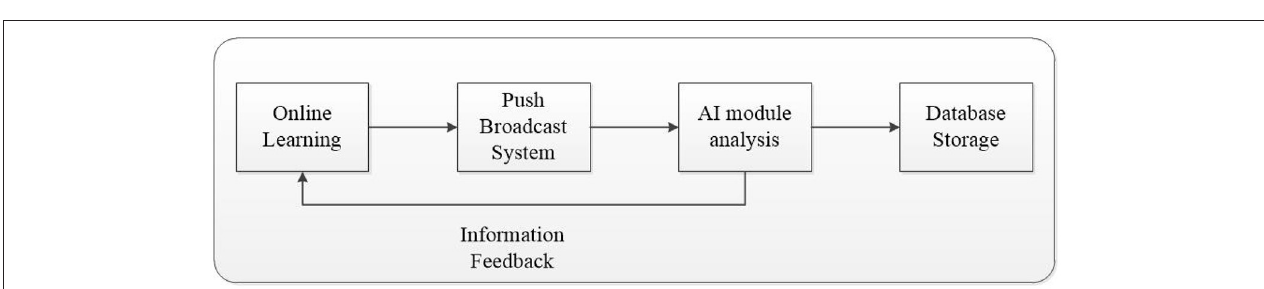
FIGURE 1 | System model.